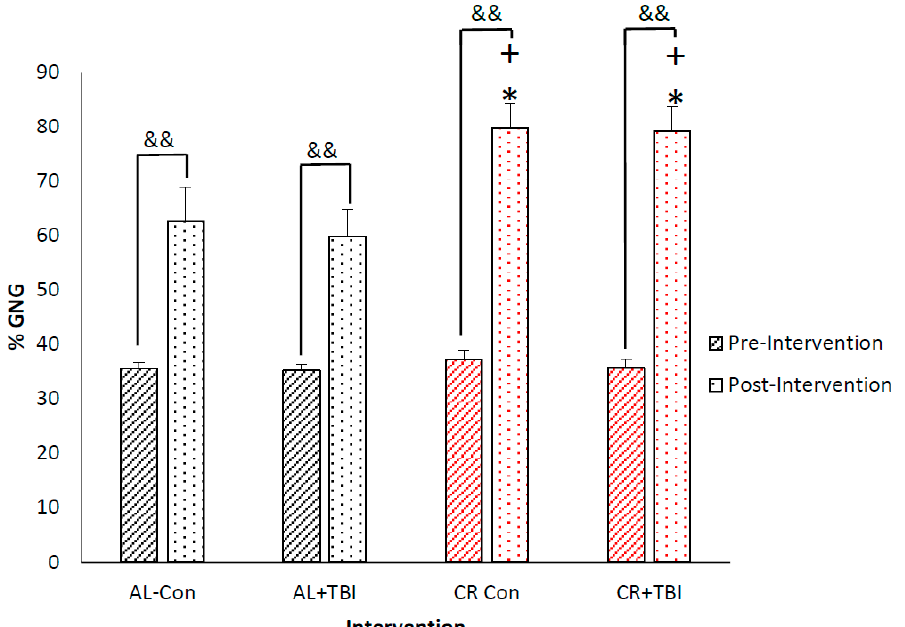
Figure 3. Caloric restriction significantly increased endogenous glucose production independent of TBI. Percent fGNG pre-intervention and 13 days post-caloric restriction in AL-Con, AL-TBI, CR-Con, and CR-TBI groups. Black angled lines indicate AL fed pre-intervention fGNG, black dotted columns indicate AL fGNG 13 days post-intervention. The red angled lined column indicates CR fed pre-intervention fGNG; the red dotted column represents CR fGNG 13 days post-intervention. * p ≤ 0.001 from AL-Con, + p ≤ 0.001 from AL+TBI, && significantly different from pre-intervention ≤ 0.001.